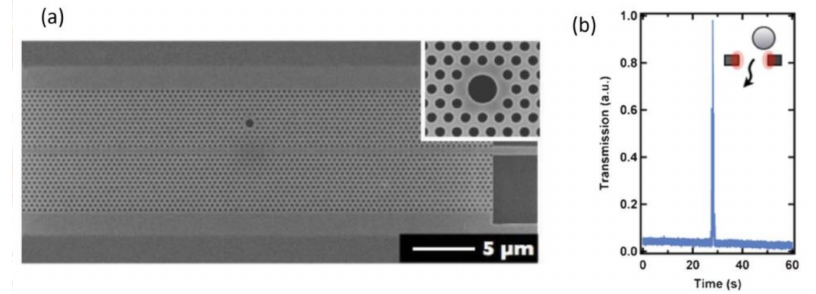
Figure 3. ( a ) Scanning electron micrograph of a PC structure, lattice constant 420 nm, showing the large point defect side-coupled with the PC waveguide defect; ( b ) experimental record of transmission through the structure when a particle is moving through the cavity as illustrated in the inset. Adapted with permission from reference [86]. Copyright (2013) Royal Society of